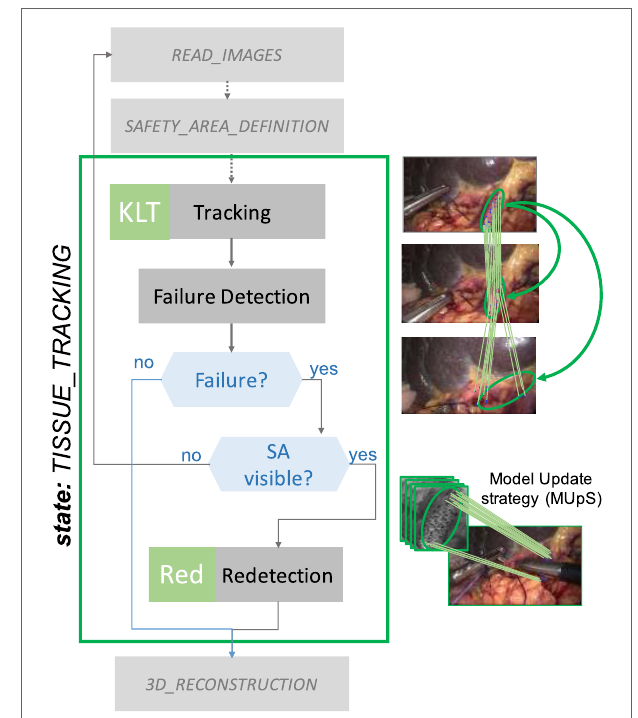
FigUre 5 | TISSUE _ TRACKING state workflow . LT-SAT tracker is used to track the SA. If a failure in the tracking happens, due to (i) partial occlusion, (ii) total occlusion, and (iii) SA out of the field of view, a redetection strategy is used to recover the pose of the SA in the new frame. The Model Update Strategy (MUpS) updates a vector of models to be used for the redetection, taking into account the changes of appearance of the SA model.